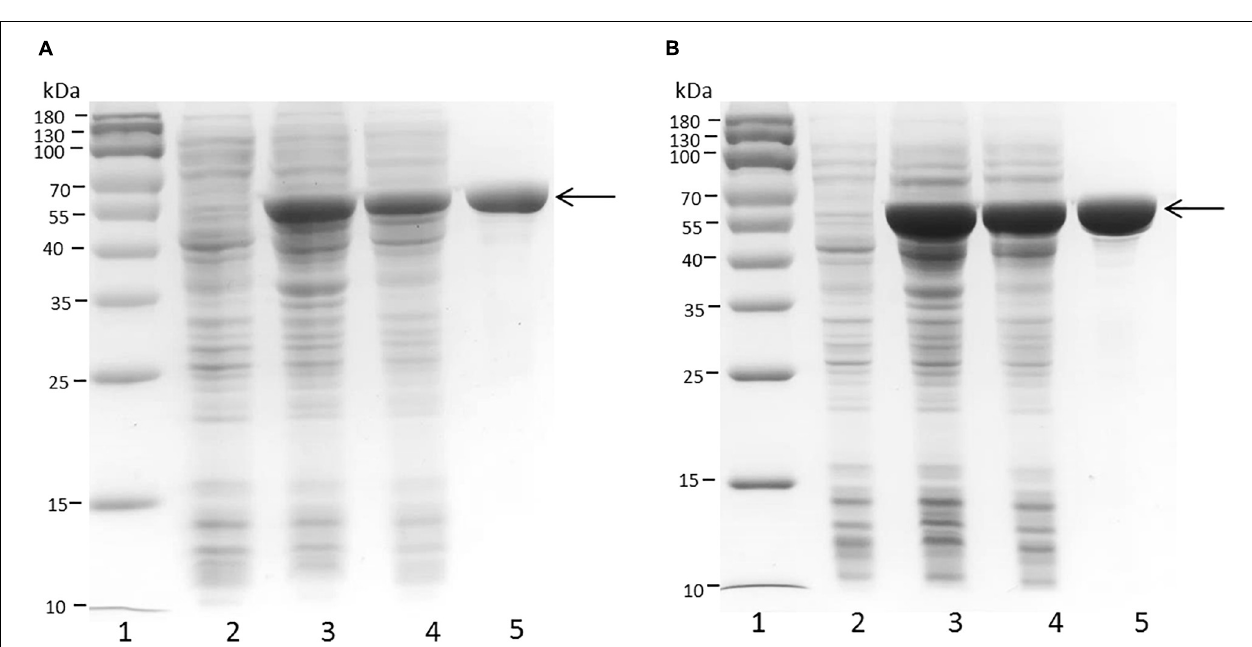
FIGURE 1 | Phylogenetic analysis of PB_3262 and PB_3285. Phylogenetic analysis of PB_3262 and PB_3285 was executed based on Clustal W multiple alignments with identified CS/DS sulfatases from bacteria. The phylogenetic tree was built with MEGA version 7.0.26 software using the neighbor-joining algorithm. The percentage of replicate trees in which the associated taxa clustered together in the bootstrap test (1,000 replicates) is shown next to the branches.